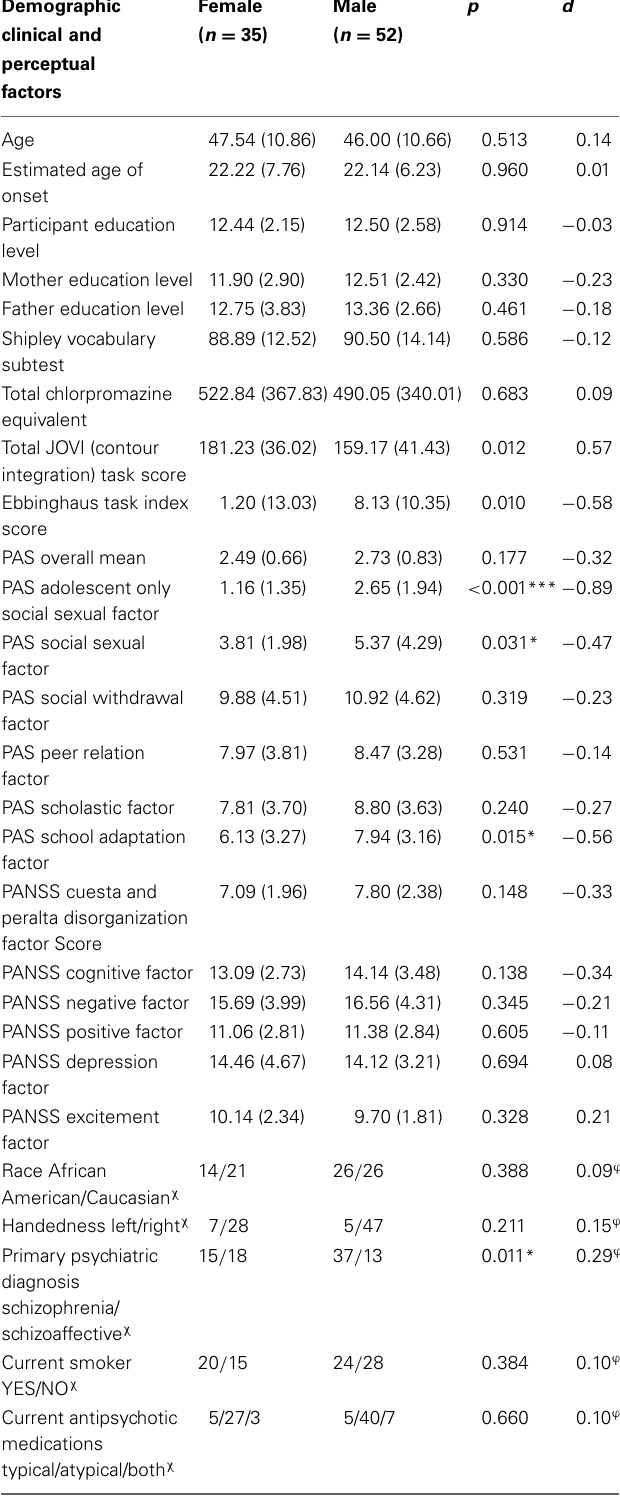
Table 1 | Demographic clinical and perceptual characteristics based on participant